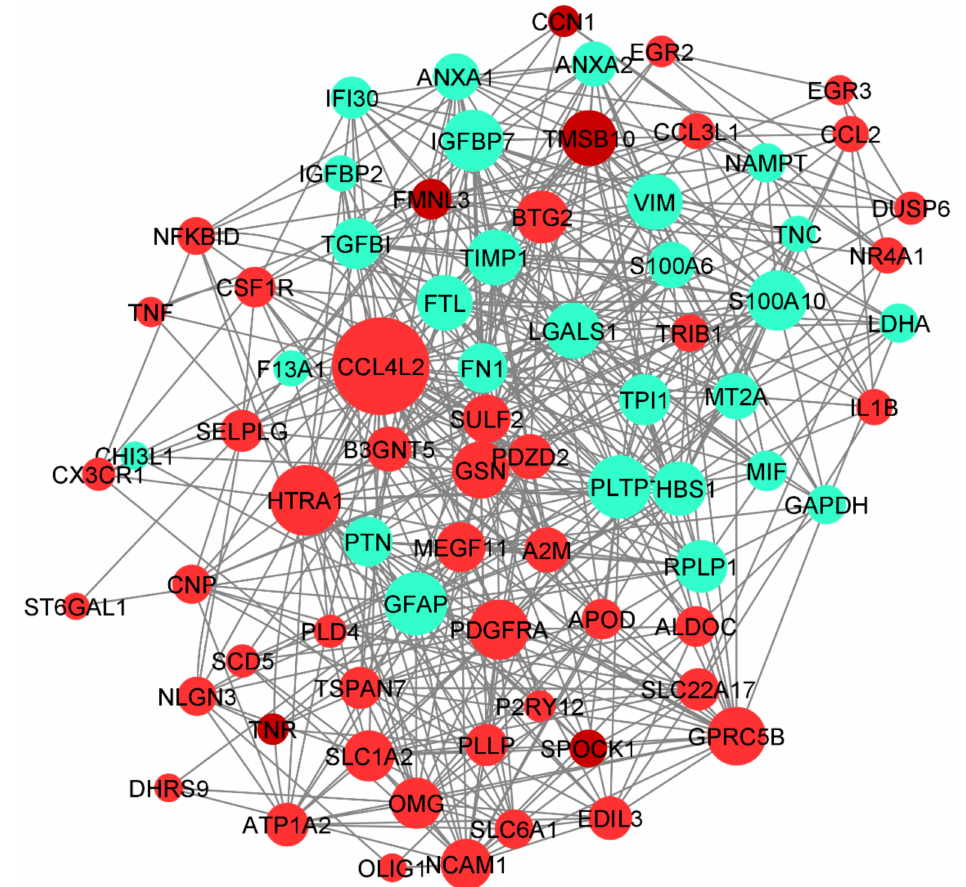
Figure 9. Co-expression network of DEGs constructed using Humanbase and visualized with Cy- toscape. Proteins are represented with color nodes; the size of the nodes represents the degree param- eter. The networks for up- and down-regulated genes are represented in red and cyan,